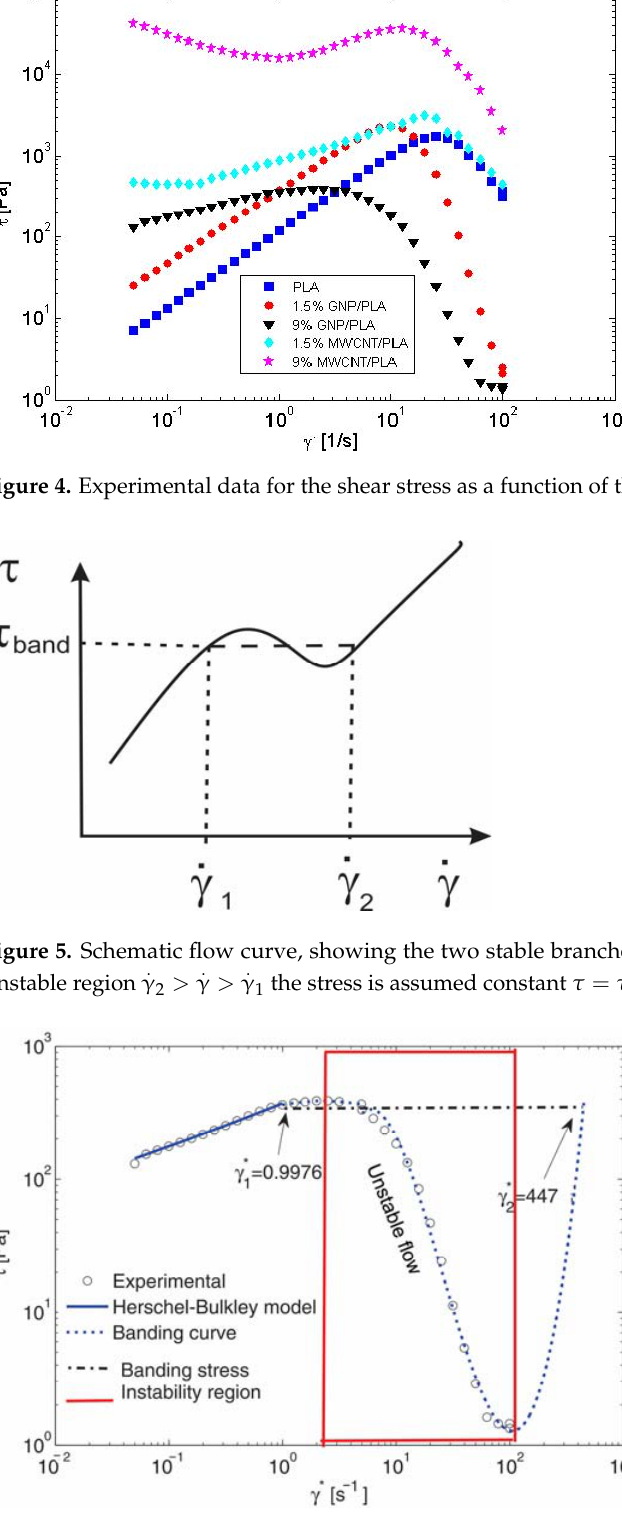
Figure 6. The shear stress modeling of 9 wt.% GNP/PLA: experimental data (o); banding curve with a blue dotted line; Herschel–Bulkley model with a solid blue line; shear stress as the constant (cid:0) . (cid:1) = (cid:0) . (cid:1) τ band = τ γ 1 τ γ 2 with a dash-dotted black line. The unstable flow region between the maximum and minimum shear stress and the corresponding shear rates is marked as a red box, i.e., unstable flow with negative shear stress